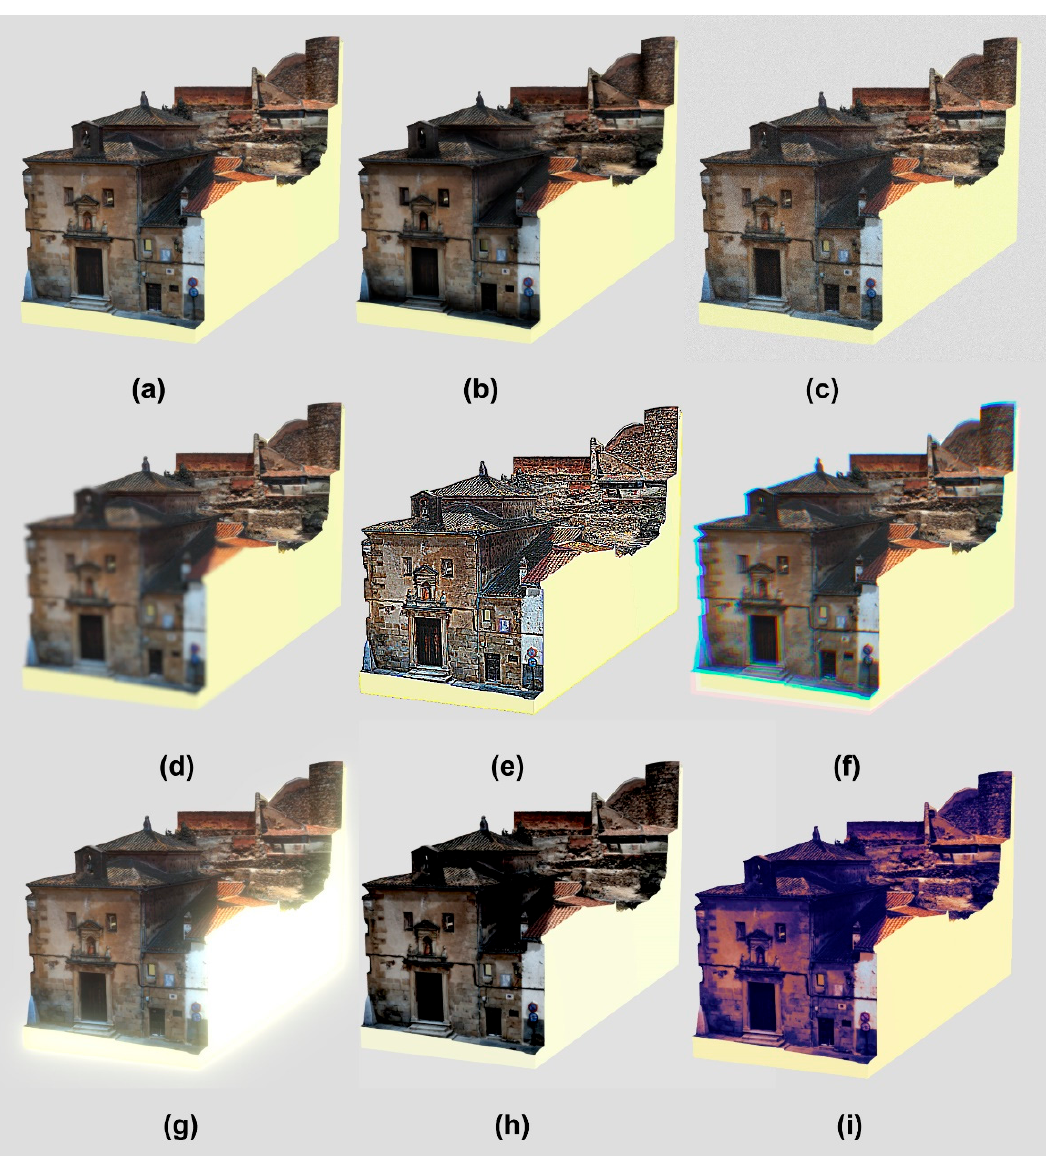
Figure 18. Different customizations in PBR of the preconfigured materials in milestone VI.1. Cus- tomization of the clipping region in orange and red and, finally, replacement of all texture maps by a solid red color: ( a ) Screen Space Reflections (SSR), ( b ) Screen Space Ambient Occlusion (SSAO); ( c ) Grain, ( d ) Depth of Field (DoF), ( e ) Sharpness, ( f ) Chromatic Aberration, ( g ) Bloom, ( h ) Vignette, Tone Mapping and ( i ) Color Balance.